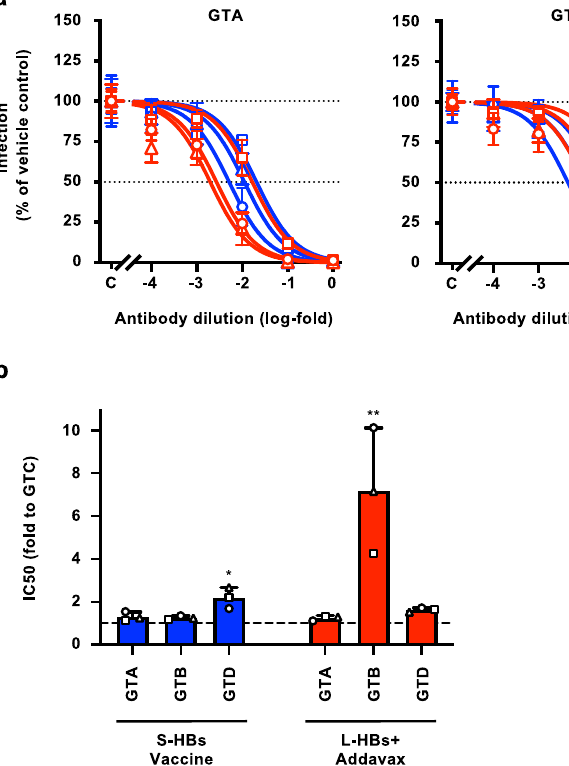
assessedbymeasuringtheNLactivitiesininfectedcells7daysafterinfection. b The IC 50 values were calculated by drawing the dose – response curves with the log (inhibitor) vs. normalized response model and indicated the folds to that of HBV/ NL-WT(GTC).Themean±SDofthreeanimalsisindicated.* P =0.0139bytwo-tailed paired t -test. ** P =0.0171 by two-tailed paired t -test. Source data are provided as a Source Data fi